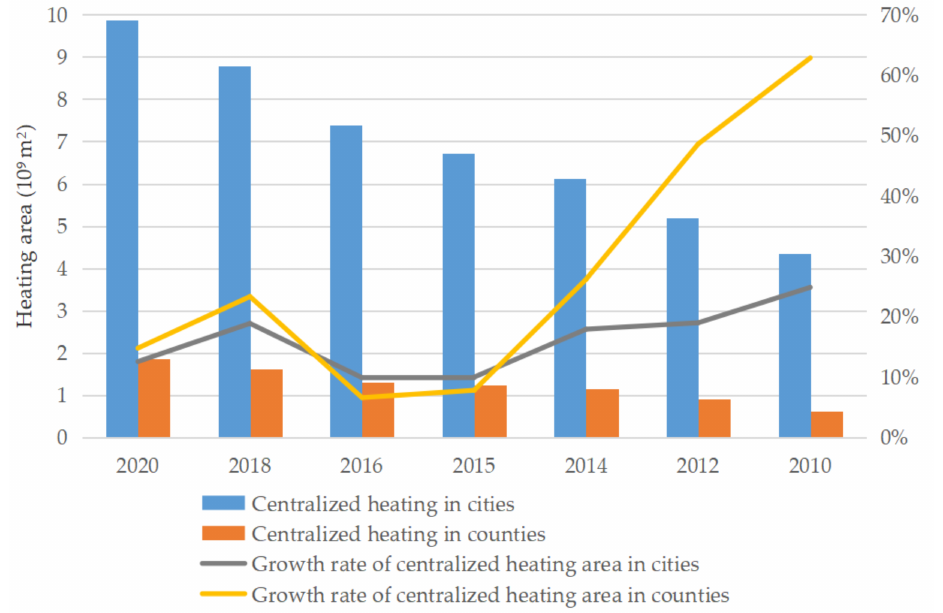
Figure 1. Change in heating area in Chinese cities and counties. (Data from China Urban and Rural Construction Statistical Yearbook